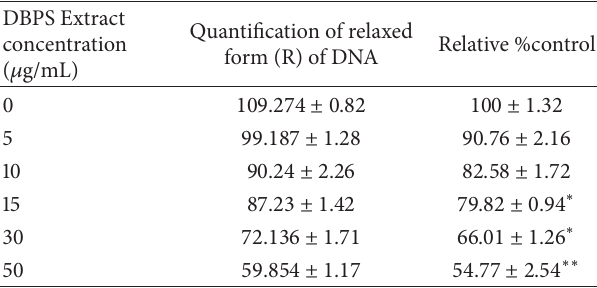
Table 2: Inhibition of DNA nicking by hydroalcoholic extract of Desmostachya bipinnata against Fenton’s